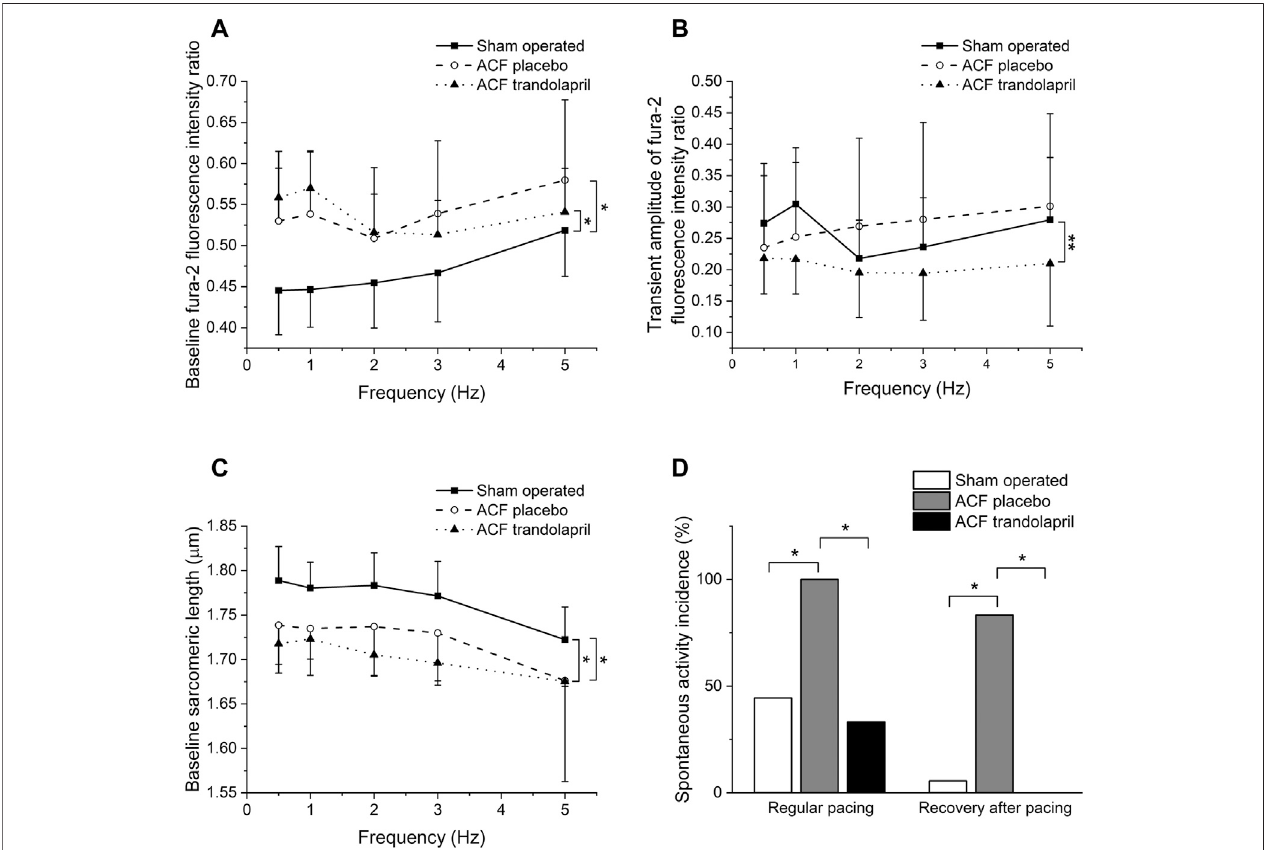
FIGURE 5 | Intracellular Ca 2+ and sarcomeric length in isolated ventricular myocytes. (A) Baseline Fura-2 fl uorescence ratios in isolated ventricular myocytes from sham-operated rats ( n (cid:1) 8), ACF rats ( n (cid:1) 8) and ACF rats with trandolapril ( n (cid:1) 8). (B) Transient amplitudes of Fura-2 fl uorescence ratios in isolated ventricular myocytes from sham-operated rats ( n (cid:1) 8), ACF rats ( n (cid:1) 8) and ACF rats with trandolapril ( n (cid:1) 8). (C) Baseline sarcomeric length in isolated ventricular myocytes from sham- operated rats ( n (cid:1) 8), ACF rats ( n (cid:1) 8) and ACF rats with trandolapril ( n (cid:1) 8). (D) Incidence of spontaneous activity in isolated ventricular myocytes from sham- operated rats, ACF rats and ACF rats with trandolapril during regular pacing and during recovery after fast (5 Hz) pacing. * p <